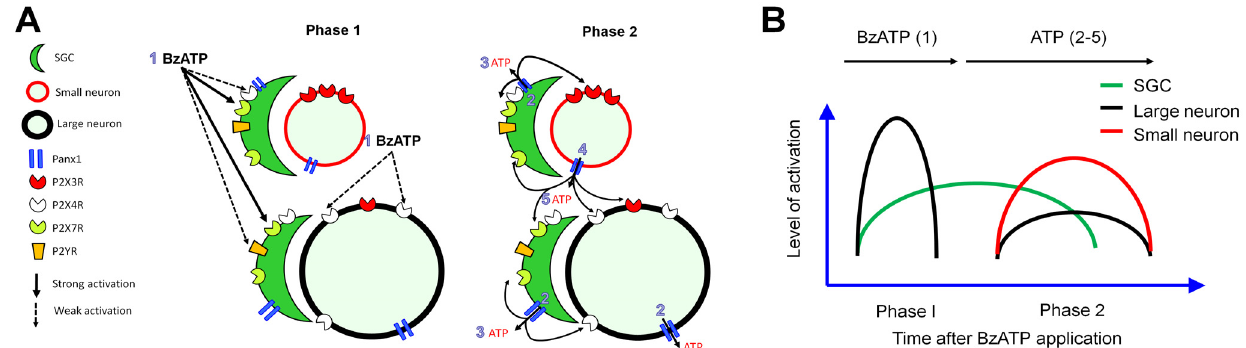
Figure 7. Hypothetical model illustrating the activation of DRG neurons and SGCs by BzATP. ( A ) 1. In phase I, BzATP strongly activates P2X7Rs, which are abundant in SGCs. To a smaller degree, BzATP may also activate other P2XR (e.g., P2X4R), which may be expressed on SGCs and large DRG neurons, as suggested by previous findings, and P2YR on SGCs. 2. In phase 2, the activation of SGCs and large neurons leads to Panx1 opening and release of ATP. 3. ATP further activates both small and large neurons and SGCs. 4. The activation of small neurons also leads to Panx1 opening and release of ATP to the extracellular space. 5. ATP, in turn, activates more SGCs and neurons. This process ends rapidly as ATP is degraded or cleared from the extracellular space. Neurons and SGCs return to the resting state, but neurons may become sensitized to subsequent stimulation. ( B ) The diagram illustrates the sequential activation of large neurons, SGCs, and small neurons after BzATP treatment.